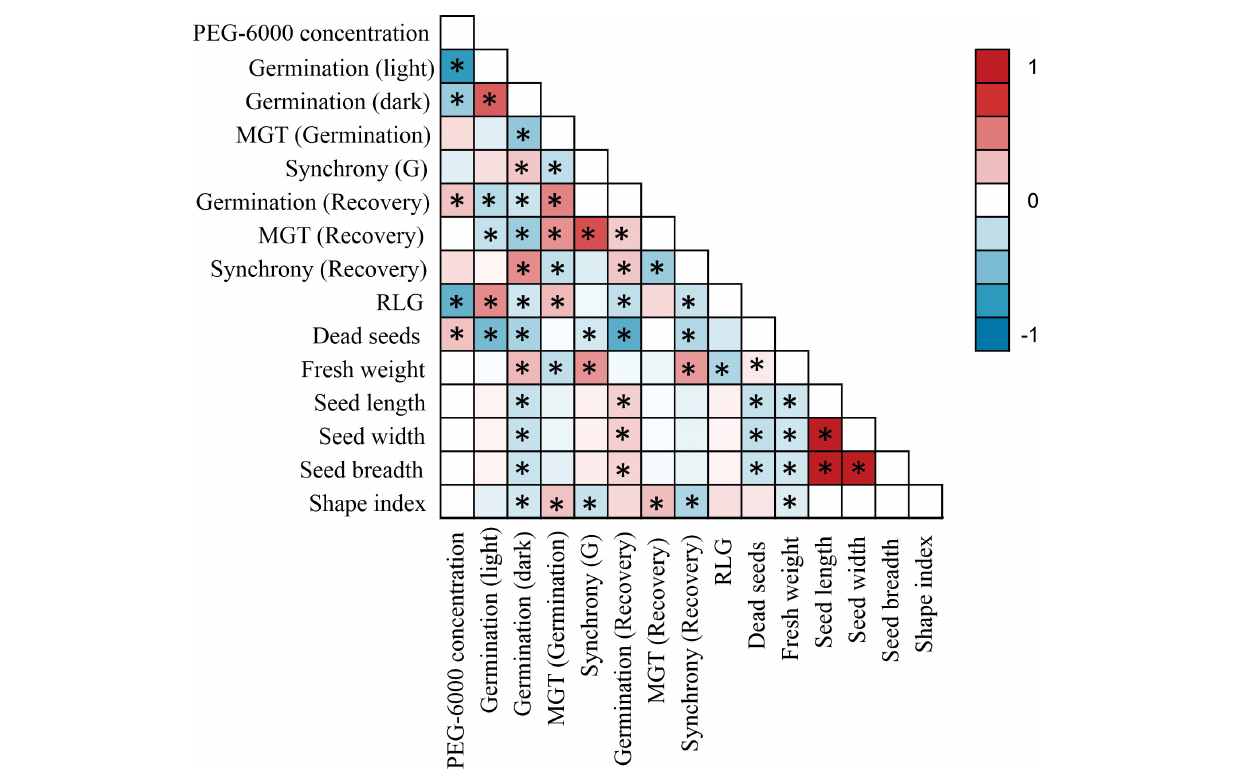
FIGURE 3 | Pairwise correlation matrix between all germination parameters and seed morphology. Asterisks ( ∗ ) denote a significant correlation of at least P < 0.05.